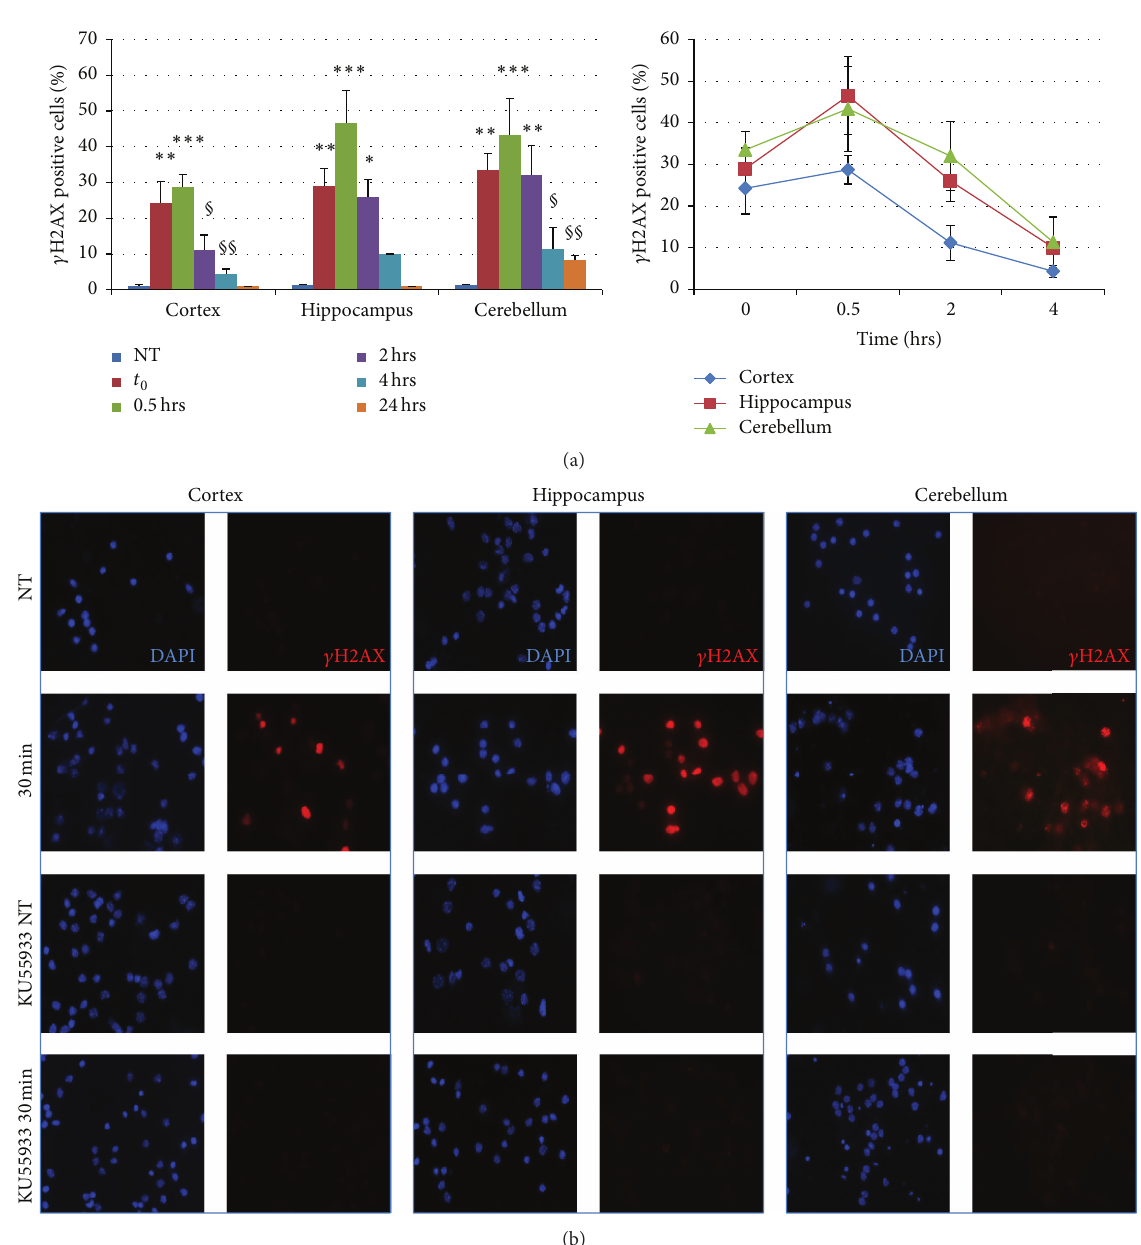
Figure 3: H 2 O 2 -induced DNA damage and repair as detected by 𝛾 H2AX foci formation in neurons derived from different brain regions. (a) Left: percentage of cells bearing 10 or more 𝛾 H2AX foci at different times after treatment with 20 𝜇 M H 2 O 2 for 30 min. One-way ANOVA and post hoc analysis Least Significant Differences (LSD) indicated a significant increase of 𝛾 H2AX positive cells immediately and 30 minutes after the treatment in all brain regions. Two-way ANOVA did not show any interaction between the treatment and the neuronal cell type. Right: kinetics of 𝛾 H2AX dephosphorylation following posttreatment times up to 24 hrs. ANOVA test shows any interaction between treatment and the three types of neurons on slopes of focus kinetics. For each time point, at least 100 nuclei were examined. Error bars indicate standard error. ∗ 𝑝 < 0.05 versus untreated (NT) by LSD test; § 𝑝 < 0.05 versus 𝑡 0 by LSD test; ∗∗ 𝑝 < 0.01 versus untreated (NT) by LSD test; §§ 𝑝 < 0.01 versus 𝑡 0 by LSD test; ∗∗∗ 𝑝 < 0.05 versus untreated (NT) by LSD test. (b) Immunofluorescence of 𝛾 H2AX (red, Ser 139; Millipore, Billerica, MA, USA) in neurons exposed to H 2 O 2 (20 𝜇 M, 30 min) with or without 1hr pretreatment with a specific ATM kinase inhibitor KU55933 (10 𝜇 M). Nuclei are stained with DAPI in blue. One representative experiment is